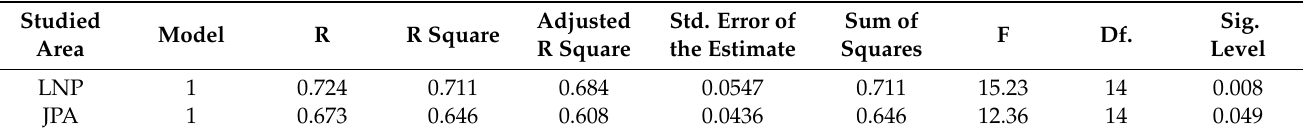
Table 5. Multivariate-regression and adjusted coefficients. Predictors: participation indicators; dependent variable: ecotourism sustainability.